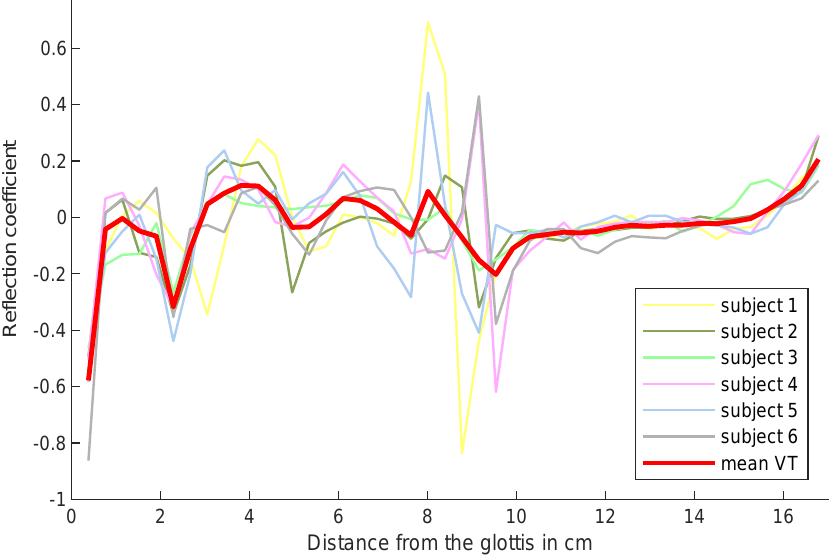
Figure 8. Reflection coefficients of the mean and individual simplified VTs as a function of distance to glottis. The geometries for the VT replicas were obtained according to the method described in Figure 2 and Section